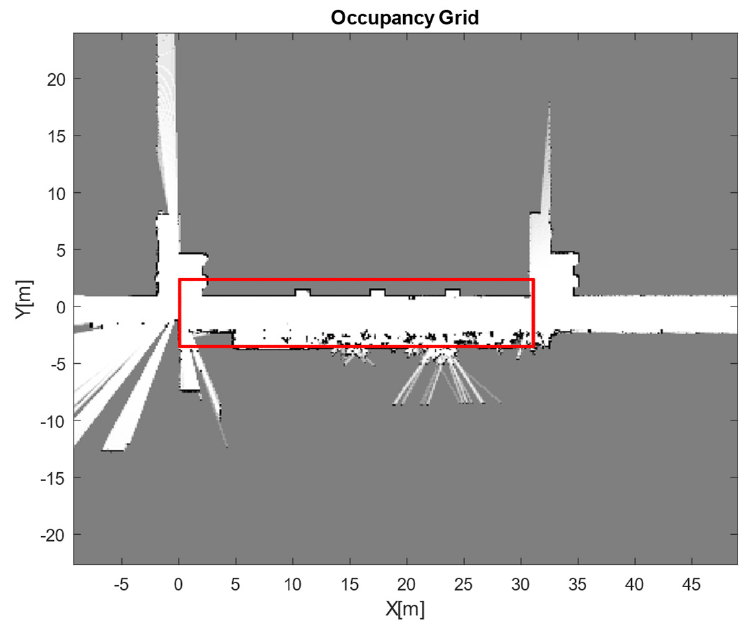
Figure 13. Generated grid map from test.